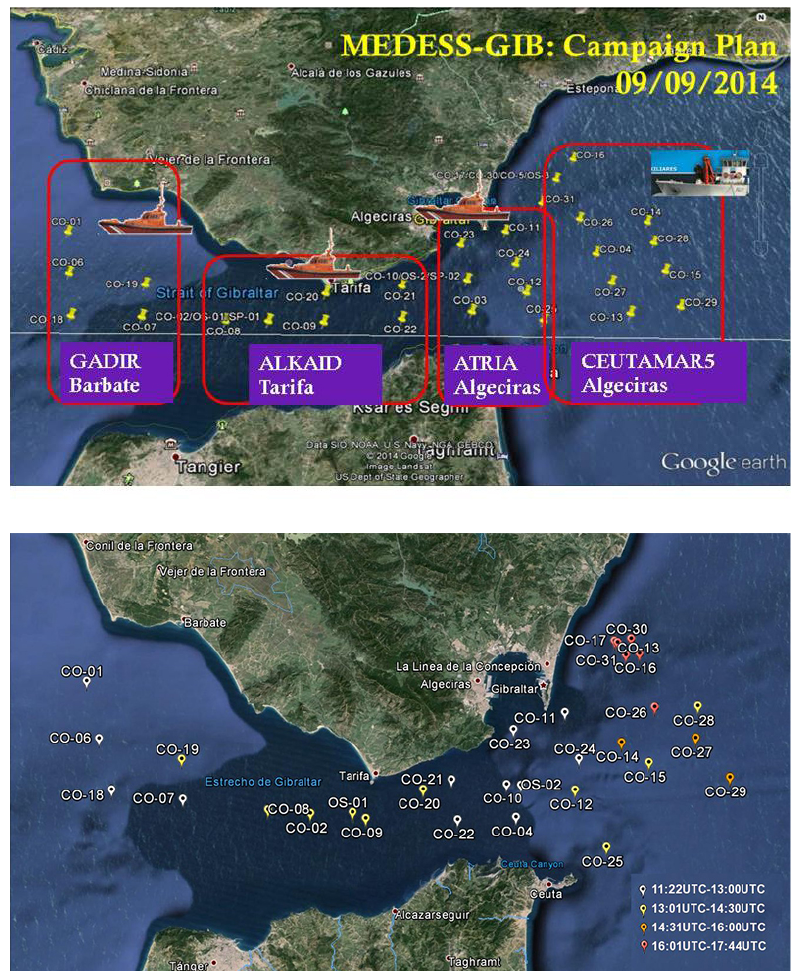
Figure 1. (a) MEDESS-GIB Drifter Buoy deployment survey plan with vessel unit distribution. CODE/Davis drifter buoys marked as CO- NN. ODI Sphere buoys marked as OS-NN and Spot buoys as SP-NN. (b) Deployment position of the buoys released in the MEDESS-GIB Campaign. A color code is used to show information on the deployment time for each